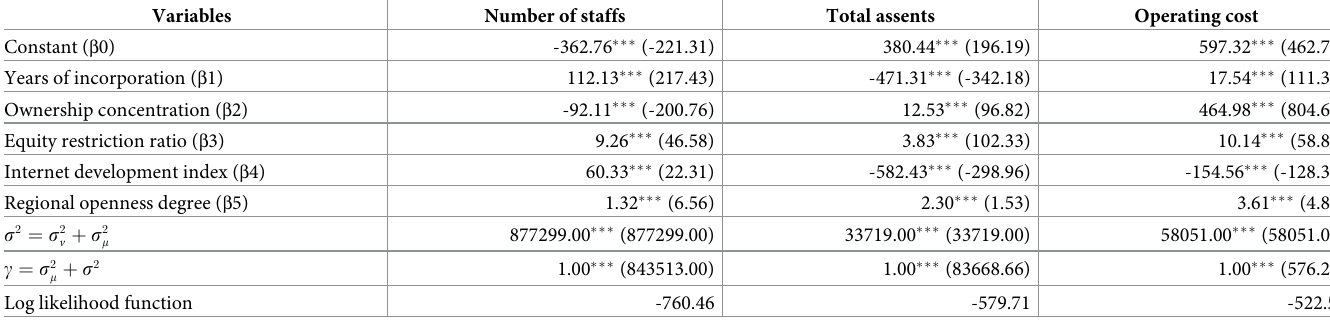
Table 3. Second-stage stochastic frontier analysis regression